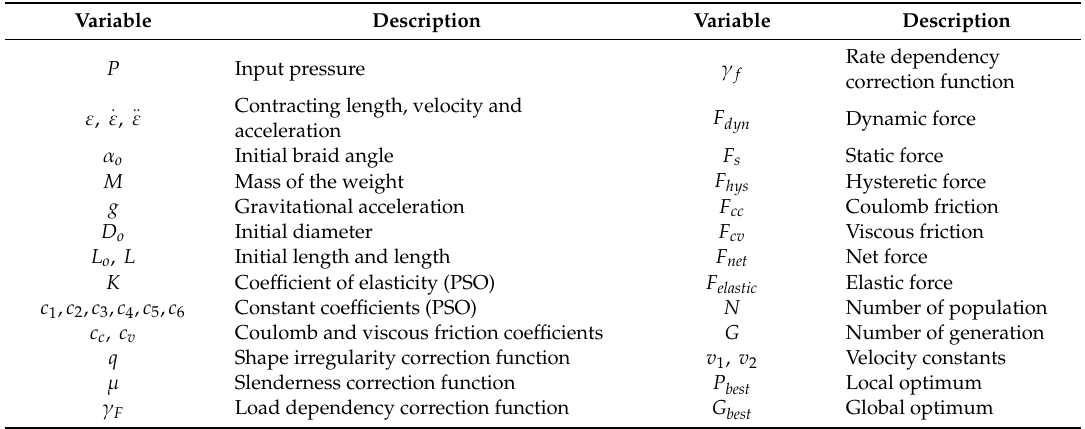
Table 2. Model parameters.